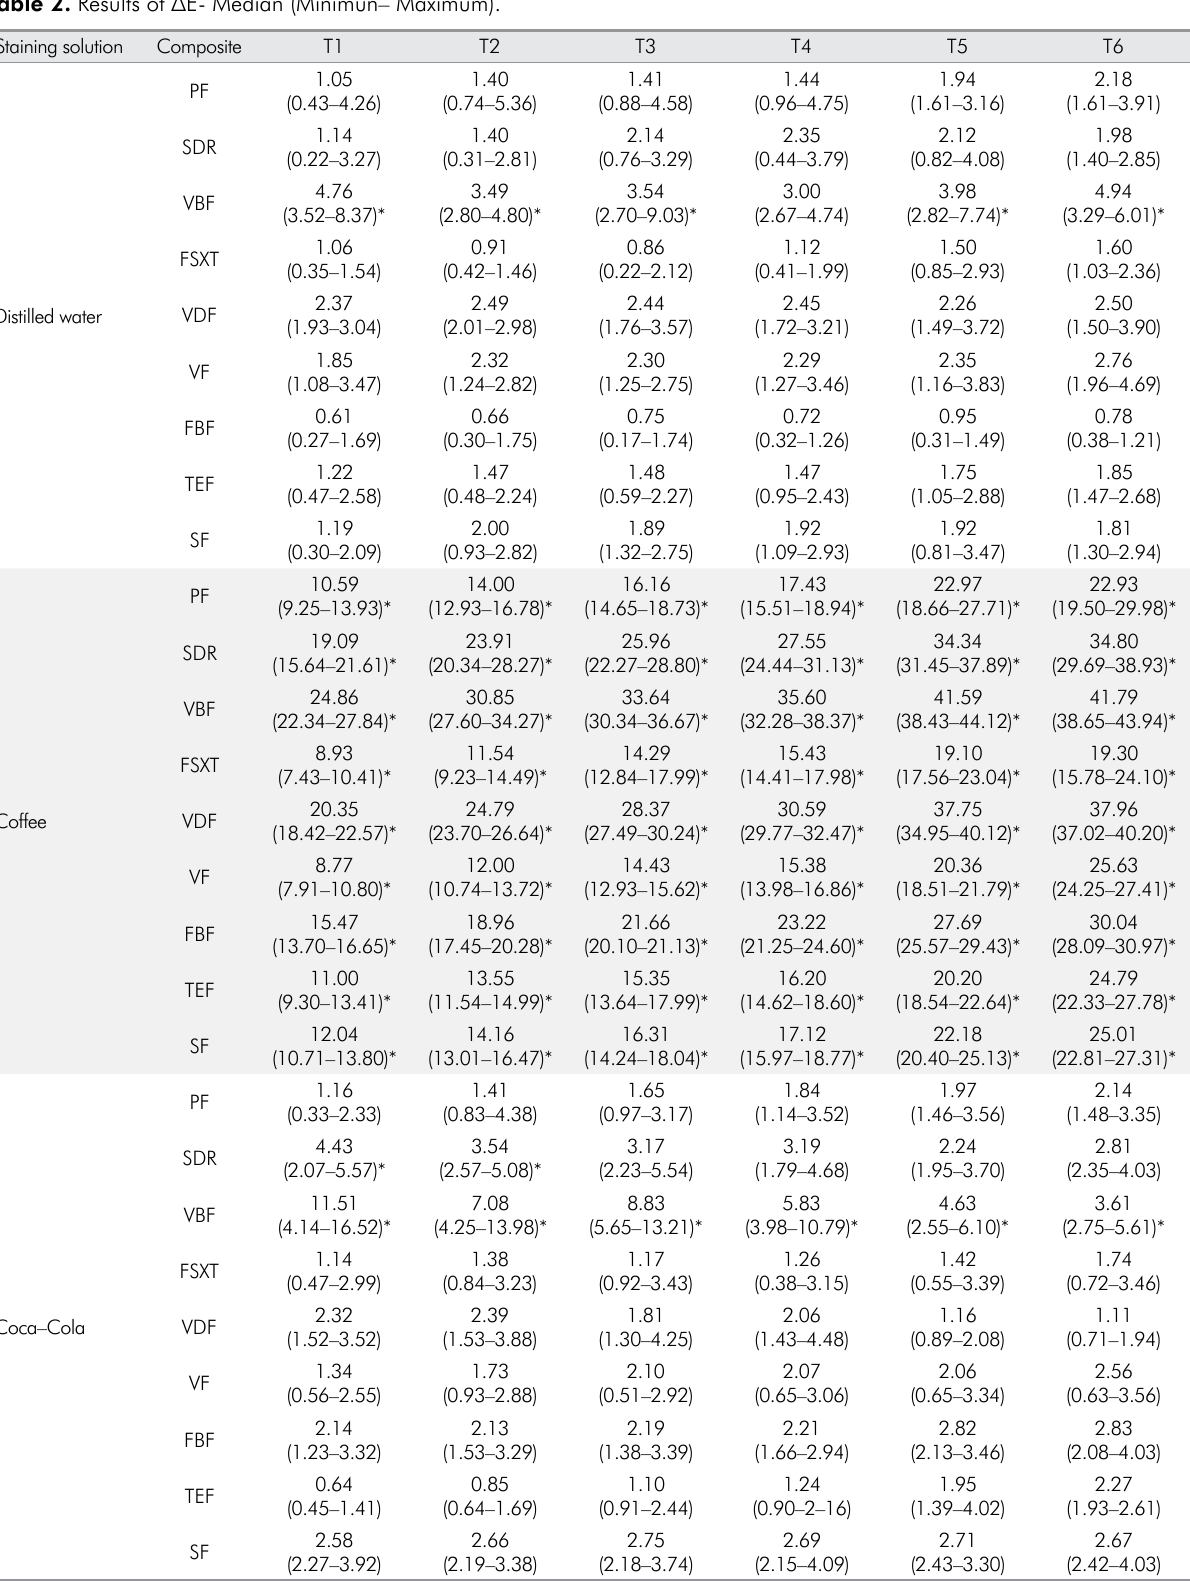
Table 2. Results of ΔE- Median (Minimun–